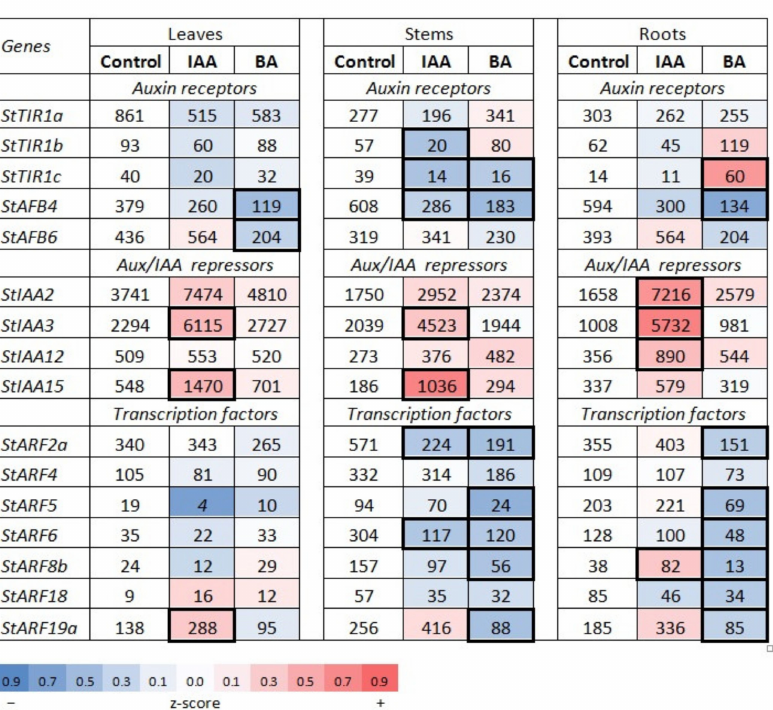
Figure 1. Effects of auxin (IAA) and cytokinin (BA) on the expression of the essential genes involved in auxin signaling in potato plants grown on medium containing 1.5% sucrose. Heatmap represents the logarithmic (lg) ratio of gene expression levels in potato plants, treated with IAA or BA, versus untreated (control) plants. Z-score of blue/red shows how strong is a decrease/increase of the expression level relative to control. Bold frames indicate cases of reliable differences (fold changes vs. control >2). Numbers in the cells represent absolute values of expression, averaged over two or more biological samples with three technical replicates each. Levels of gene expression too low (<10) to consider them as relevant are marked